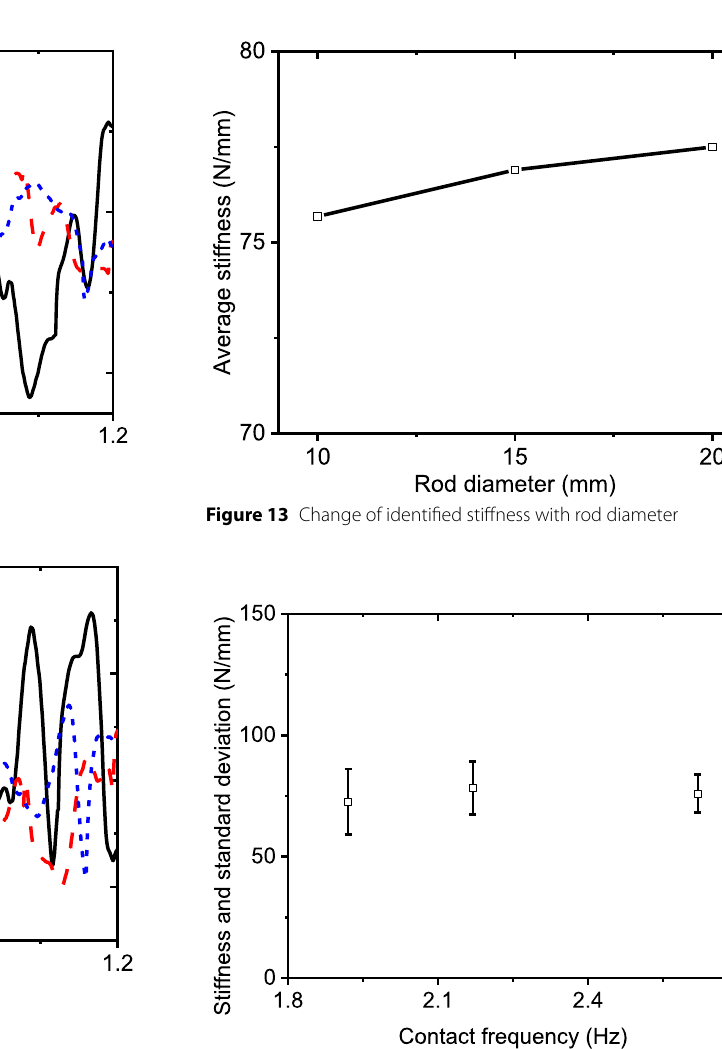
Figure 14 Contact stiffness and